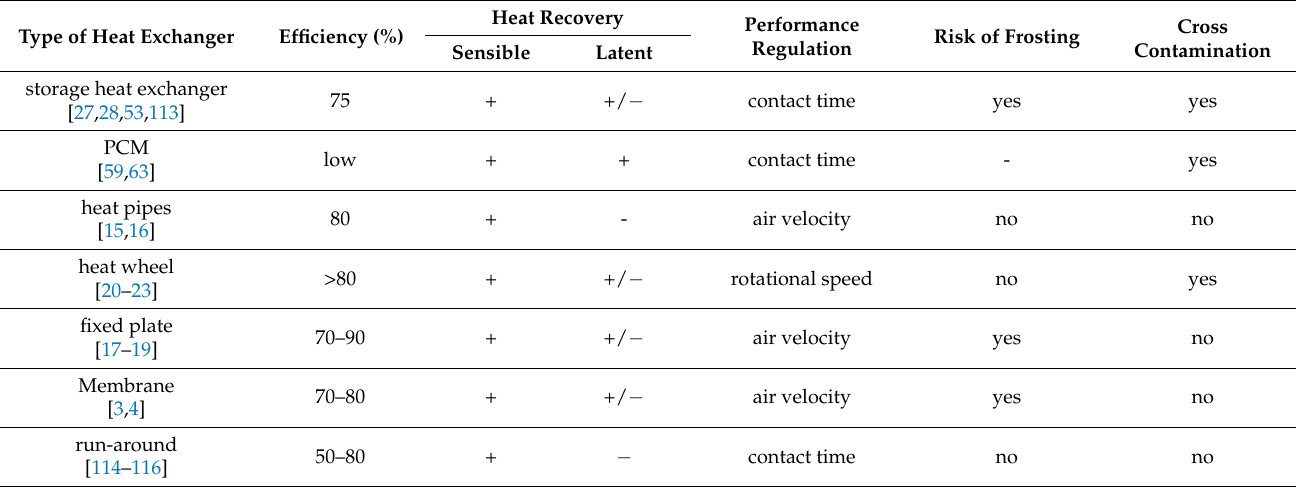
Table 2. Advantages and disadvantages of